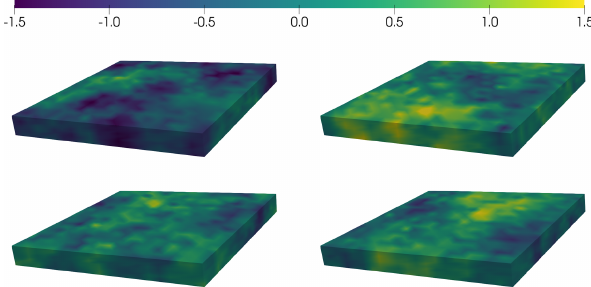
Figure 4. Samples of the flow rate pre-factor for Example 3. The top-left sample is taken as the true flow rate pre-factor. Note that the domain has been stretched in the z direction for ease of visual-